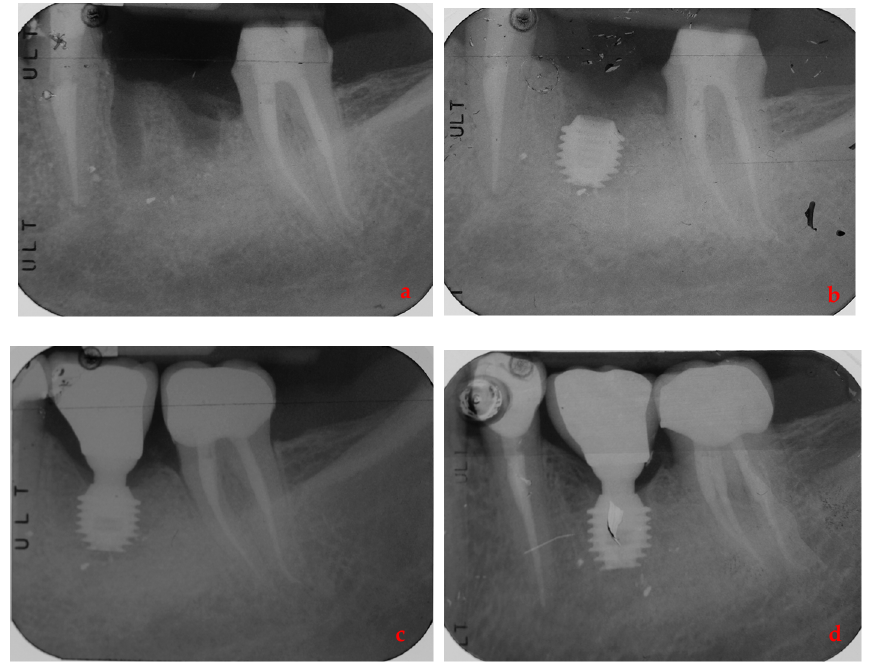
Figure 2. Single implant placed in 3.6 site (5 × 6 mm) of a female patient without history of periodontal disease: ( a ) pre-operative radiograph before implant placement; ( b ) radiograph obtained at implant placement; ( c ) radiograph obtained at time of loading; ( d ) Radiograph obtained at 3-year follow-up.